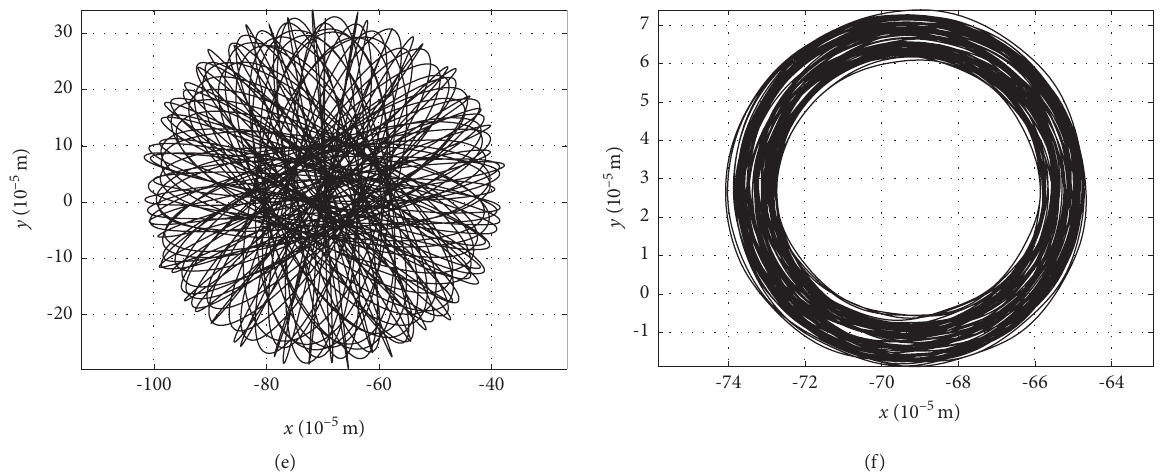
Figure 18: Orbit of disk 4 with rub-impact during hovering flight. (a) 220rad/s. (b) 226rad/s. (c) 236rad/s. (d) 252rad/s. (e) 256rad/s. (f)